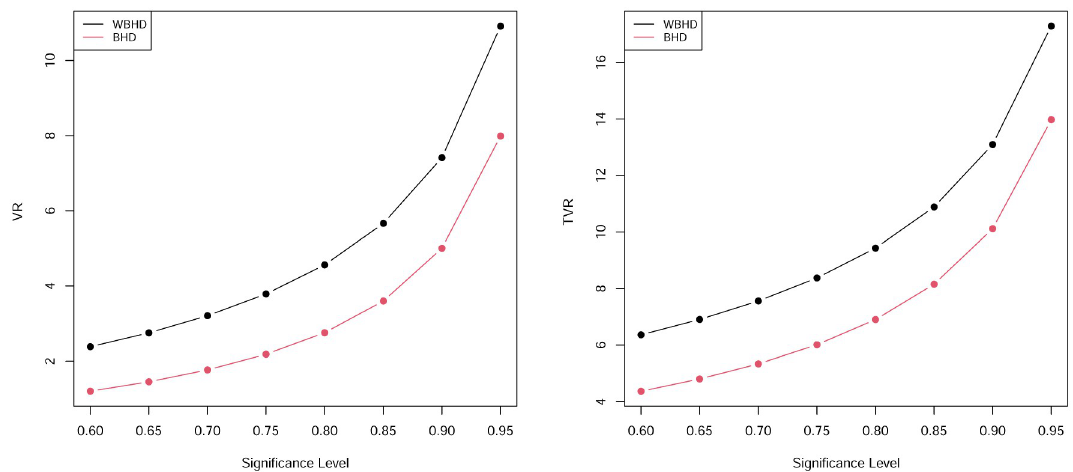
Fig 3. Graphs of the VR and TVR by the values in Table 7.